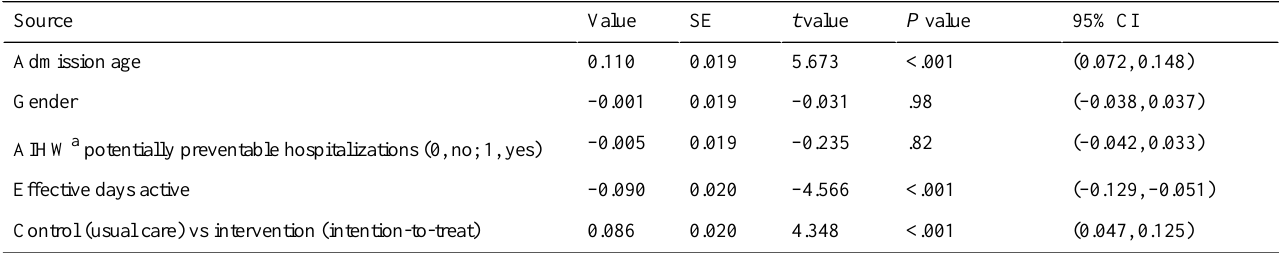
Table 3. ANCOVA summary statistics of the impact of key variables on bed days of MonashWatch patients: standardized coefficients predicting length of stay.